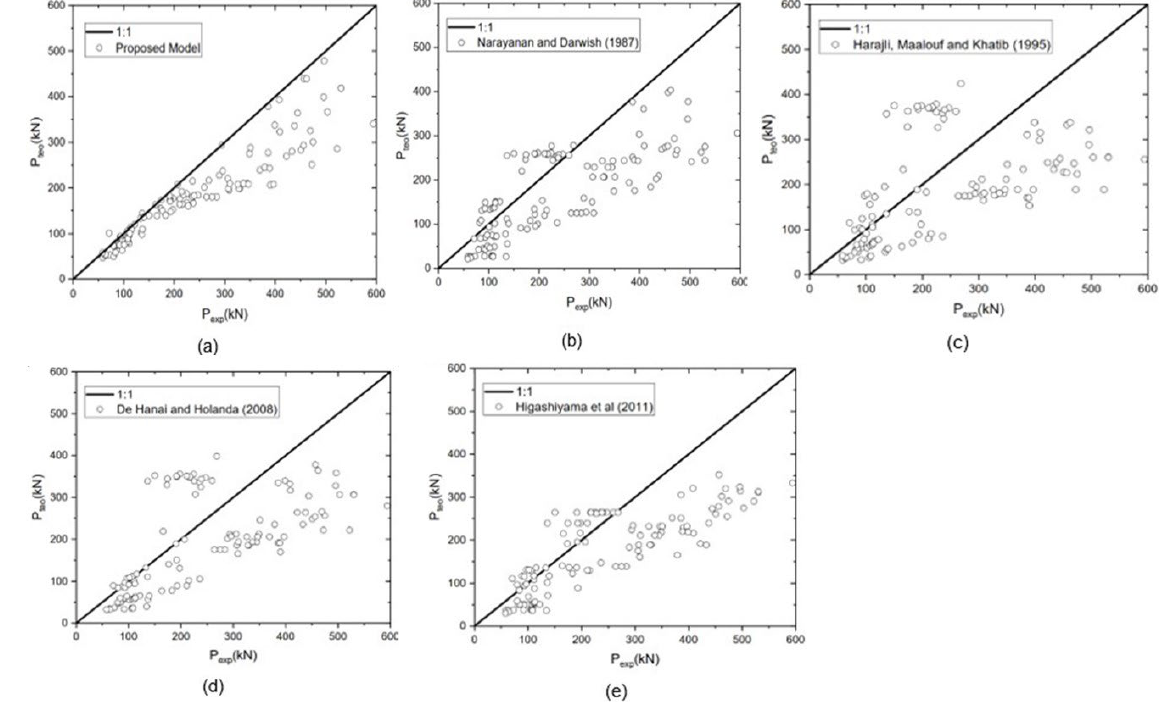
Figure 5. Comparison of rupture load prediction